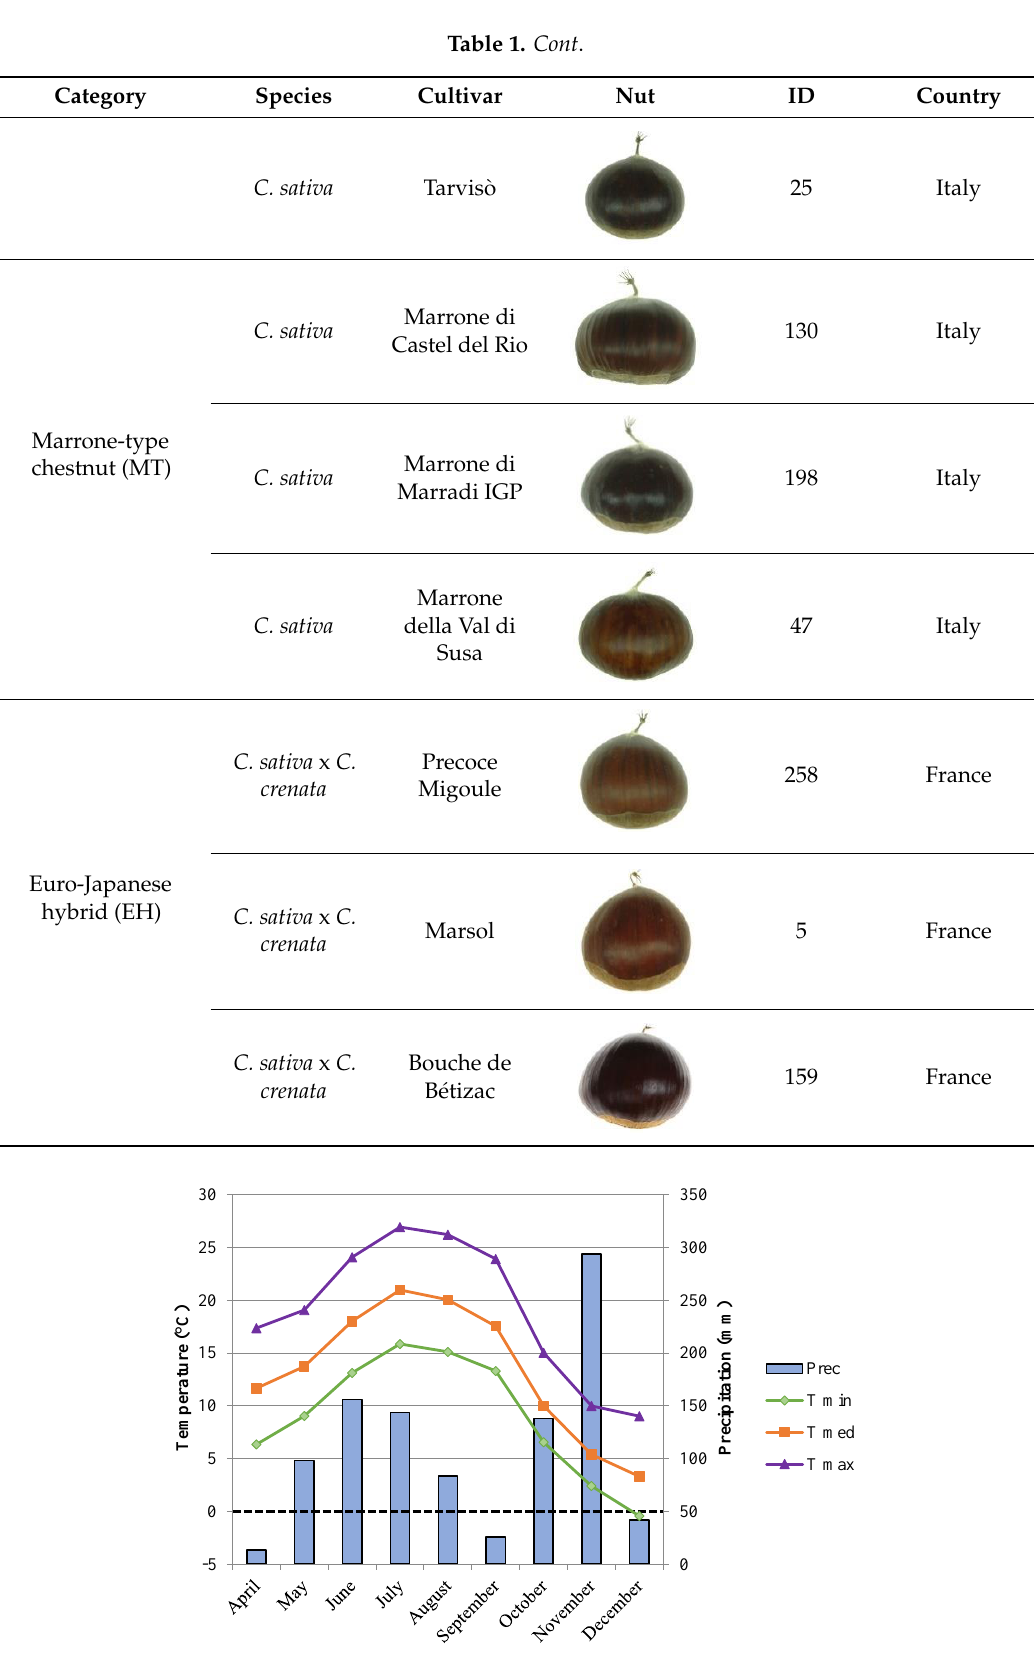
Figure 1. Monthly (maximum, mean, and minimum) temperature and rainfall values available from April to December 2018.